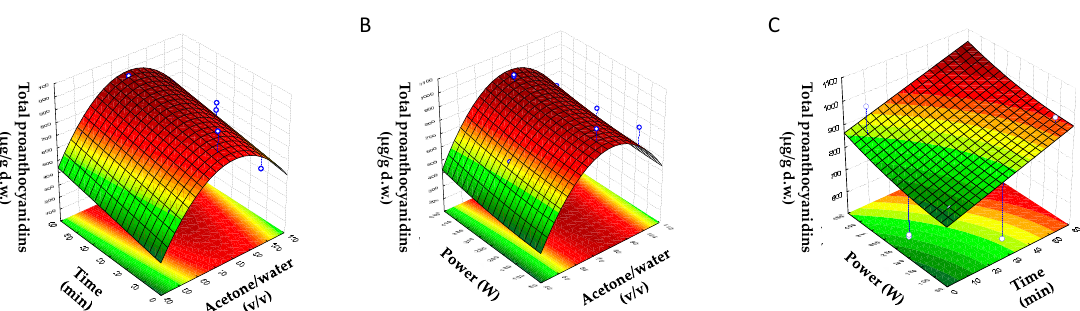
Figure 1. Response surface plots showing the combined e ff ects of process variables for total proanthocyanidins: ( A ) acetone / water (% ( v / v )) vs. time (min); ( B ) acetone / water (% ( v / v )) vs. ultrasound (US) power (W); ( C ) time (min) vs. US power (W).